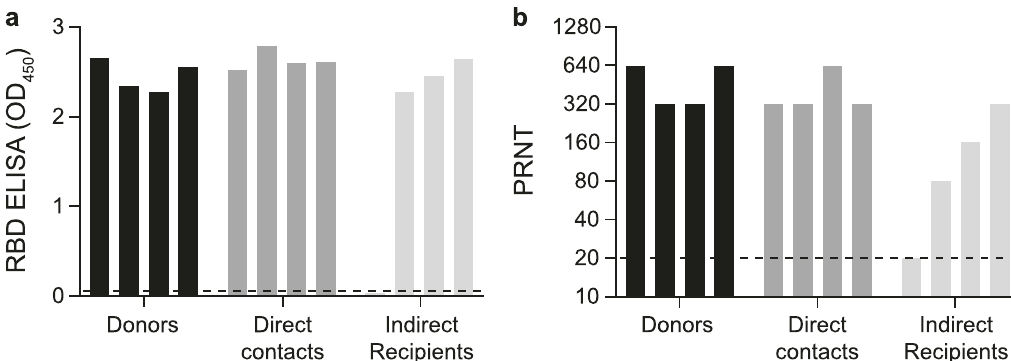
Fig. 3 Antibody responses in donor, direct contact and indirect recipient ferrets 21 dpi/dpe. Sera were collected from the donor, direct contact and indirect recipient ferrets 21 dpi/dpe and IgG responses were assessed using a SARS-CoV-2 receptor binding site (RBD) ELISA ( a ) and using a plaque reduction neutralization assay ( b ). The dotted lines indicate the detection limit of the assays. PRNT: plaque reduction neutralization titer. OD: optic density. All presera were tested negative by RBD ELISA and plaque reduction neutralization assay (OD 450 0.02 – 0.05; PRNT <